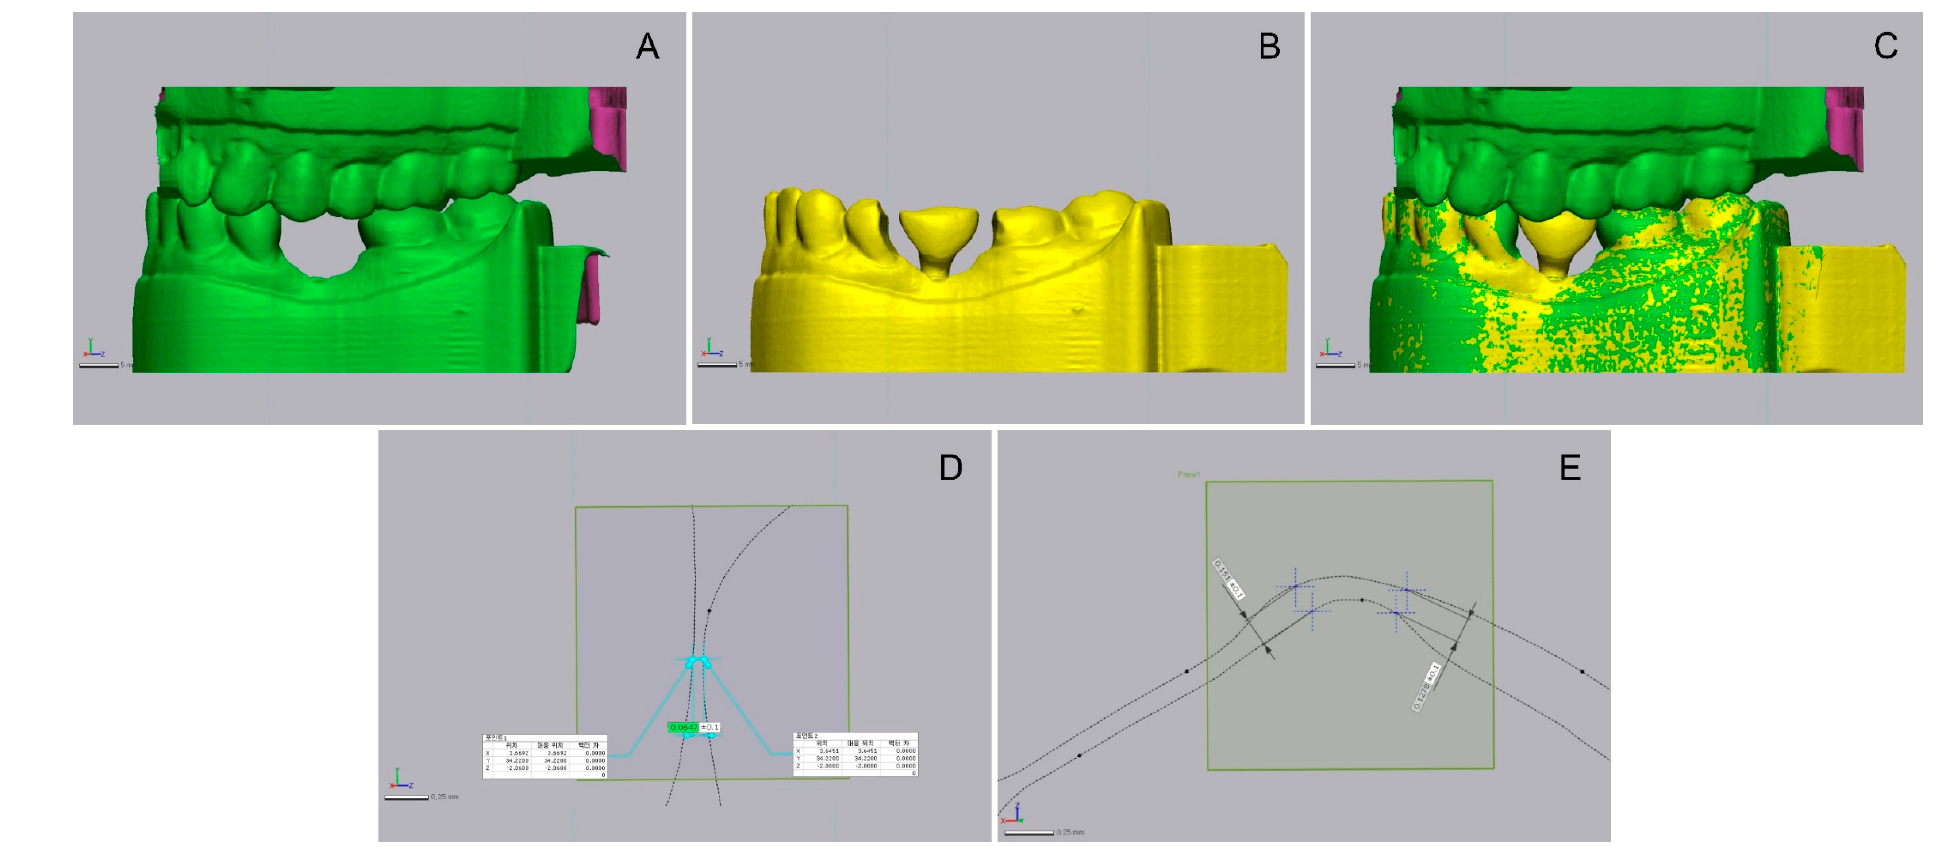
Figure 5. Procedure for superimposing scan data and measuring distance of contacts. ( A ) Scan data of the resin model without milling; ( B ) scan data of milled resin model with crown; ( C ) superimposition; ( D ) measurement of distance of proximal contact; ( E ) measurement of distance of occlusal contact.